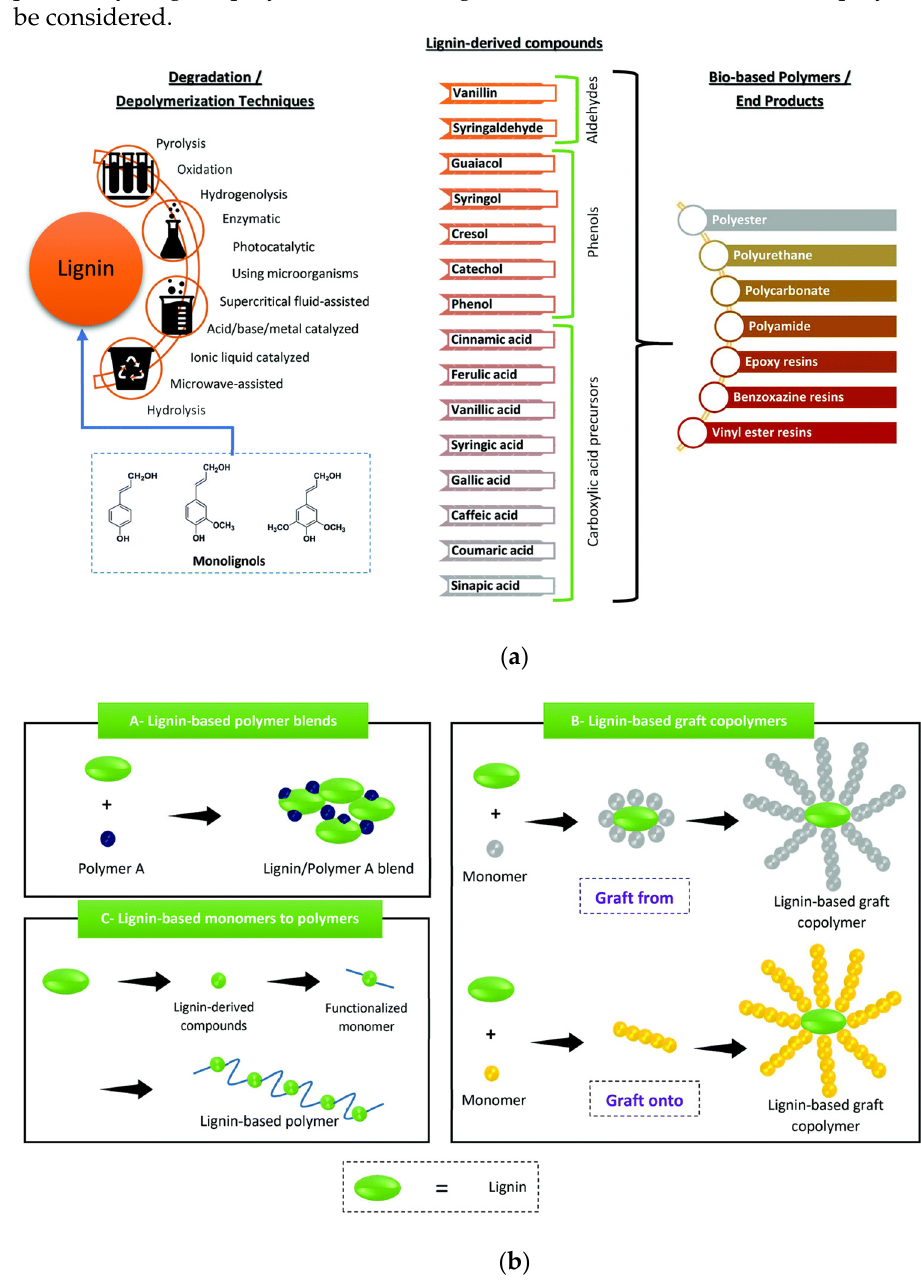
Figure 2. ( a ) Lignin depolymerization or degradation procedures and its derived monomers and polymers; ( b ) Different methods for lignin-based polymer synthesis. Reprinted with permission from Ref. [10]. Copyright 2021, Royal Society of Chemistry